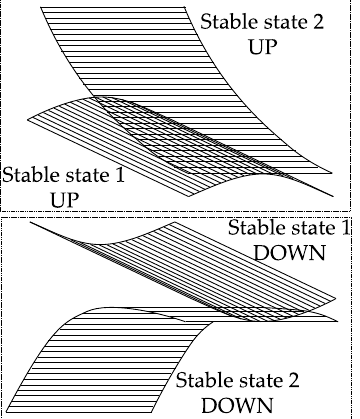
Figure 17. Bistable plates configurations.